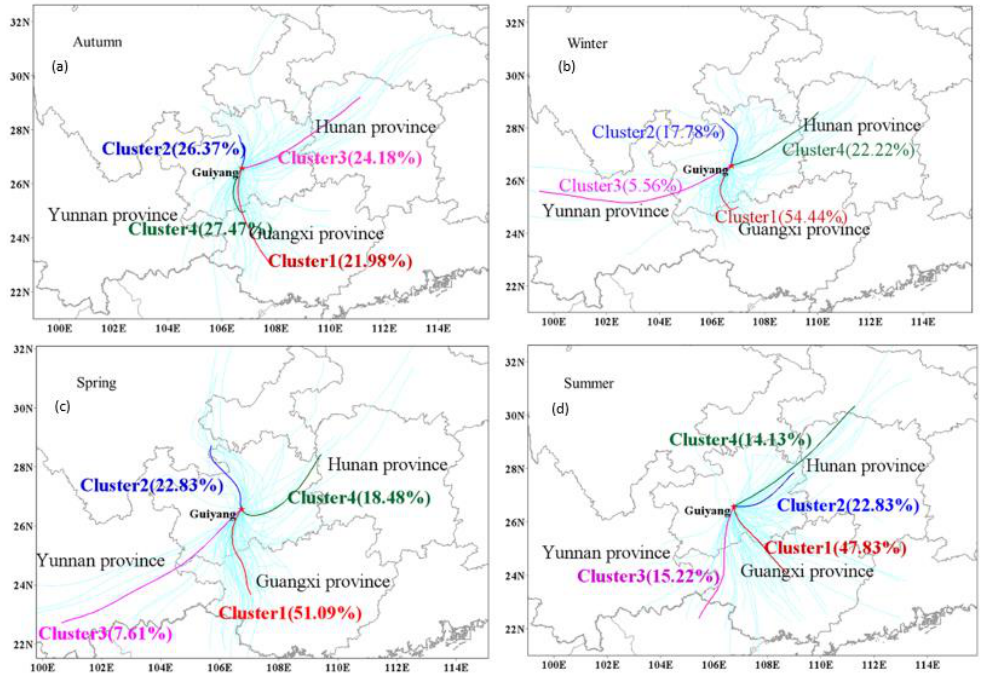
Figure 7. The 48 h backward trajectories clustering analysis of air mass arriving in Guiyang. (The thin colored lines indicate that analytical results of the 48 h air mass backward trajectories, thick colored lines indicate that the trajectory clustering results.). ( a ) In Autumn ( b ) in Winter ( c ) in Spring ( d ) in